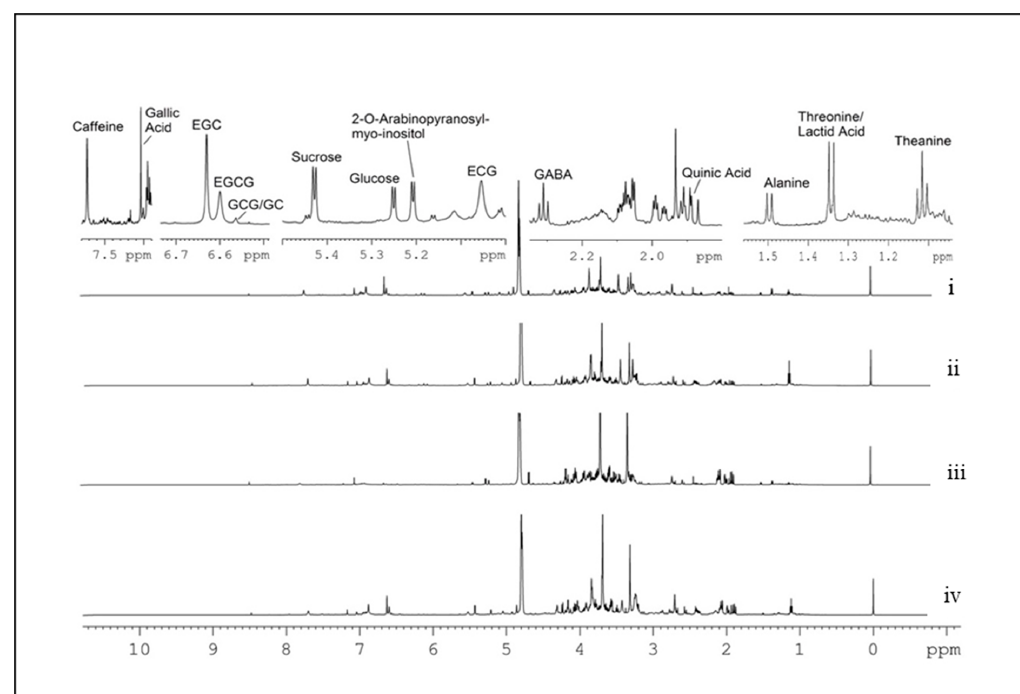
Figure 1. 1 H spectra of the four types of teas. The fourteen 1 H NMR signals selected for the statistical analysis are indicated at the top.